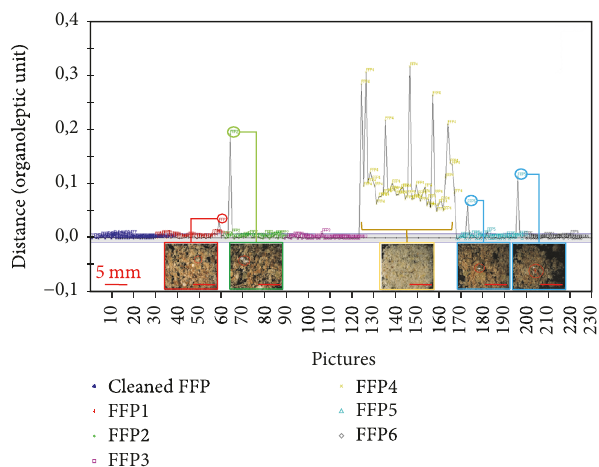
Figure 3: SQC chart (adapted from [12]). Each symbol represents a picture of the corresponding sample, based on its colour. The grey area indicates the range distance obtained by the use of cleaned FFP sample in the training phase. Symbols plotted outside the grey band indicatesample’spicturescharacterizedbythepresenceofpackaging